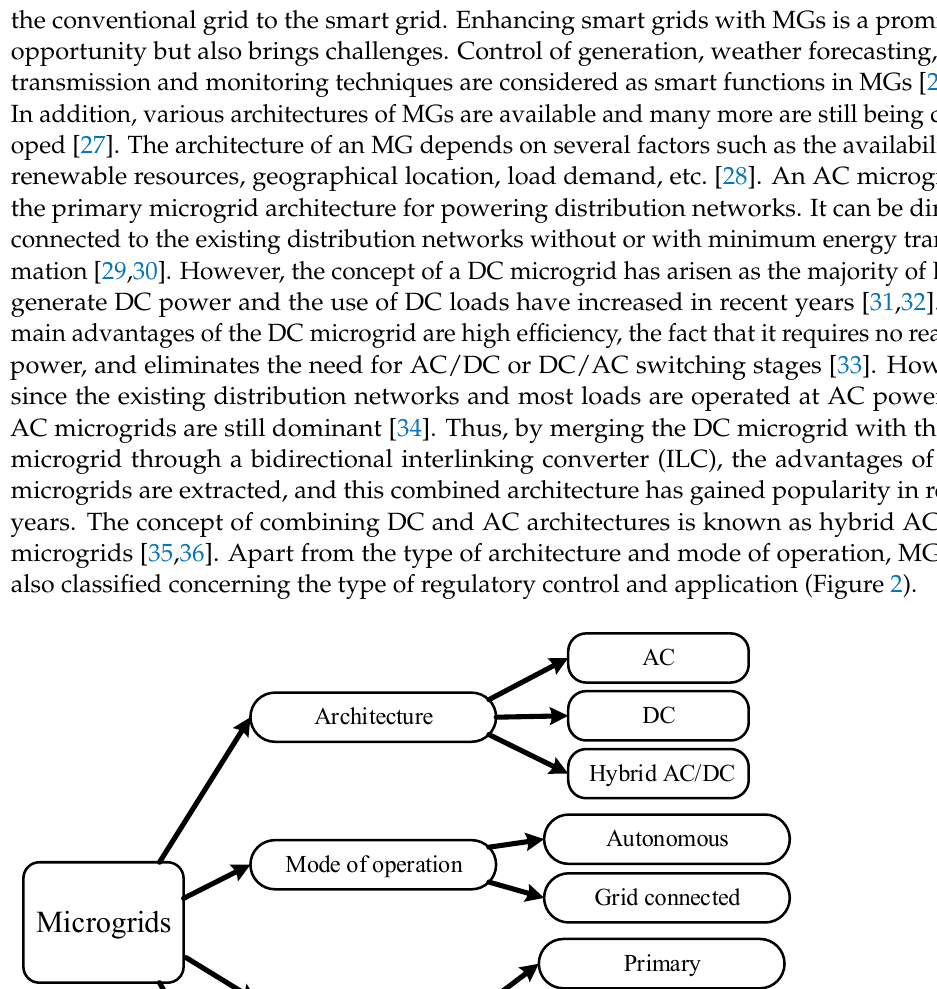
3 of 25 Figure 1. Simplified diagram of a distribution network with a microgrid (own elaboration based on data from [24]).